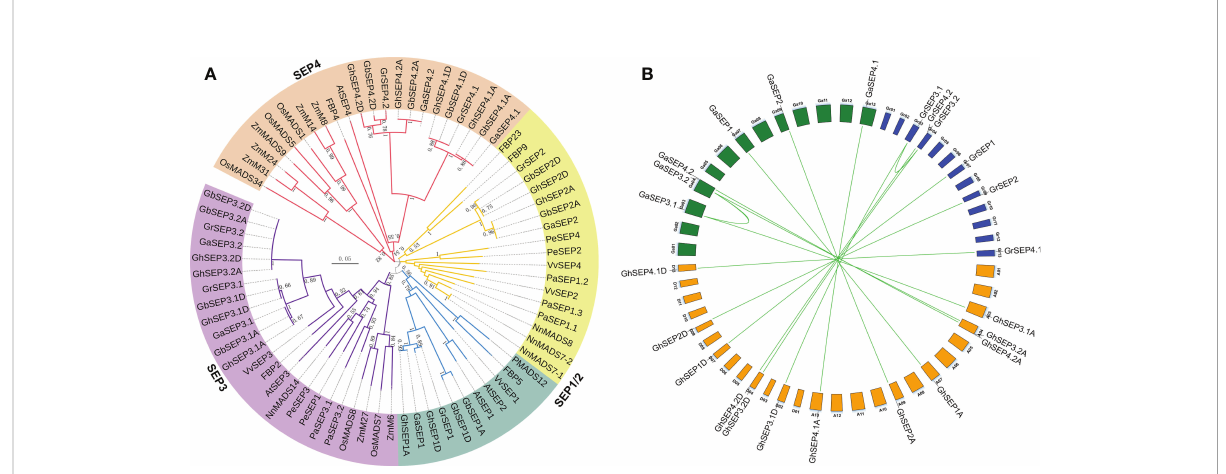
FIGURE 1 Evolution analysis of cotton SEP-like genes. (A) Phylogenetic relationships of SEP-like proteins from Gossypium barbadense, G. hirsutum, G. raimondii, G. arboreum, Arabidopsis thaliana, Petunia hybrid, Oryza sativa, Phalaenopsis equestris, Vitis vinifera, Zea mays, Nelumbo nucifera , and Platanus acerifolia . (B) Duplication events among SEP genes in diploid and tetraploid cotton varieties. Curves indicate segmental duplications. Lines link homologous genes between diploid and tetraploid